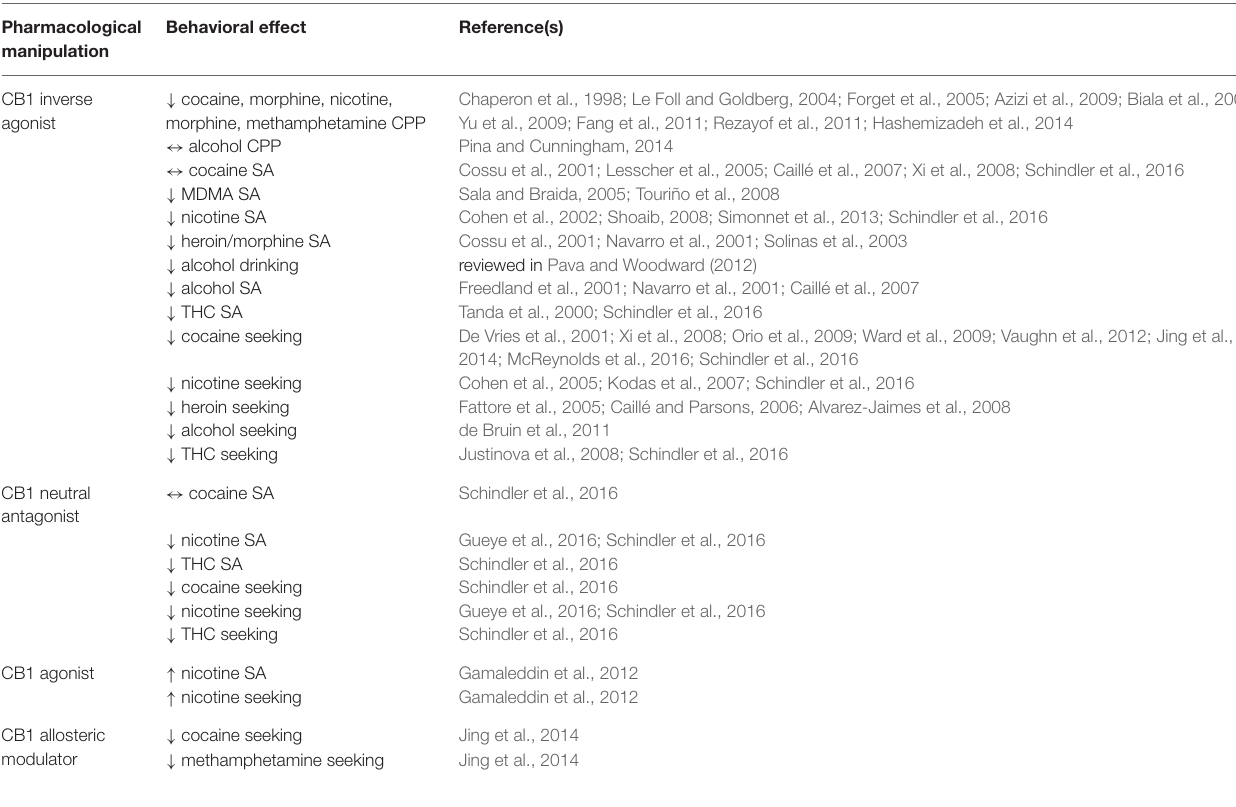
TABLE 2 | Behavioral effects of drugs targeting cannabinoid type 1 (CB1)